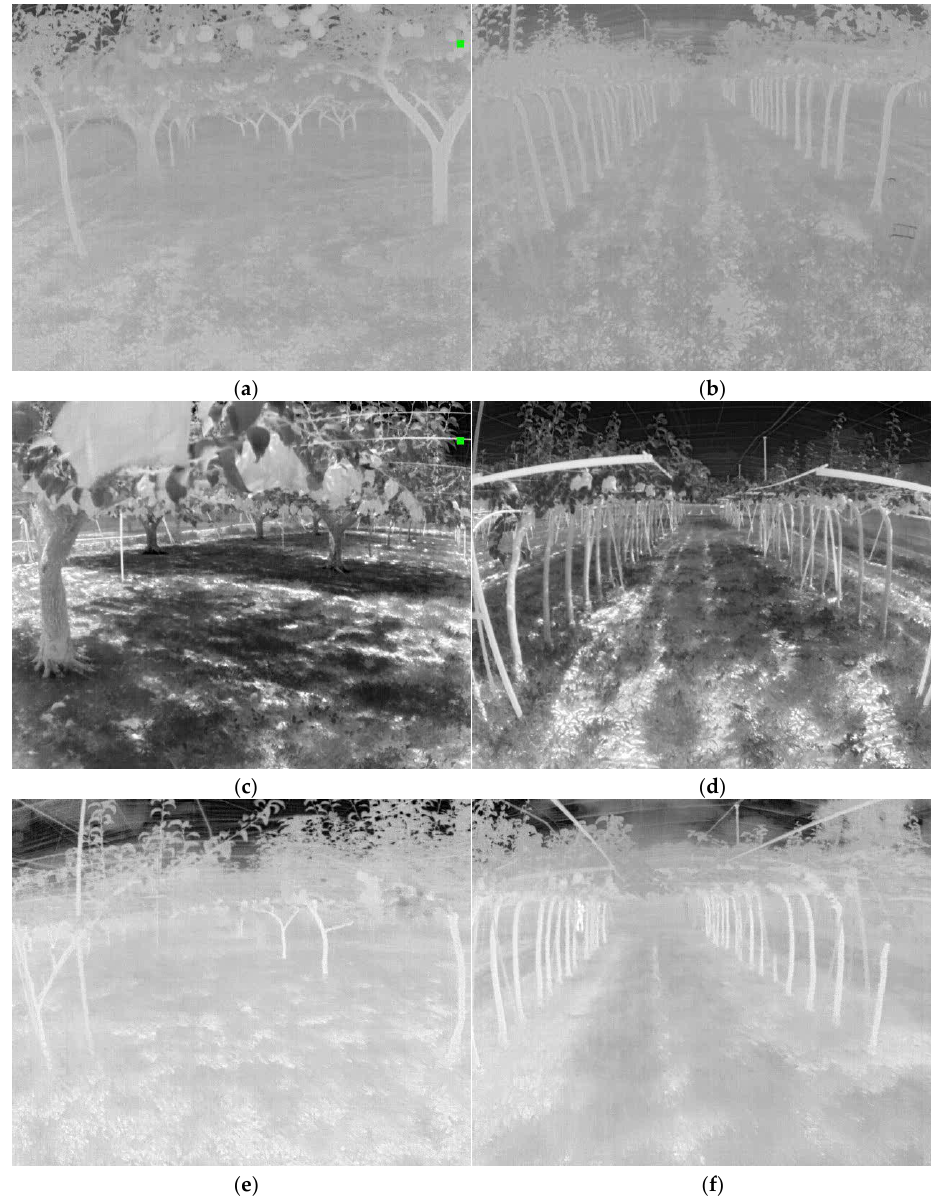
Figure 3. Analysis of thermal images under different lighting conditions: ( a , b ) no-light conditions (7 – 8 PM), ( c , d ) high-light conditions (12 – 2 PM), and ( e , f ) low-light conditions (5 – 6 PM). (7–8 PM), ( c , d ) high-light conditions (12–2 PM), and ( e , f ) low-light conditions (5–6